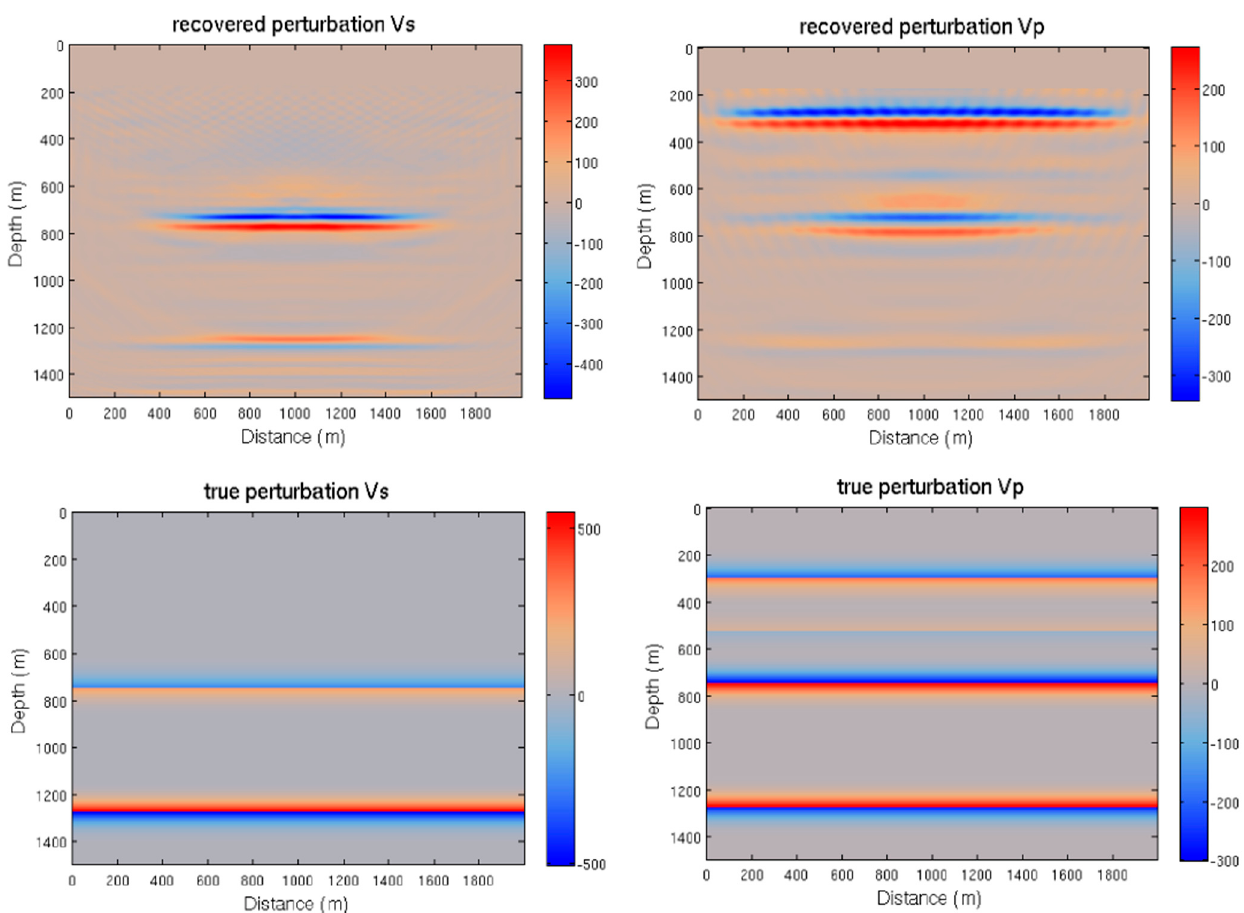
Figure 1. Minimisation for the data-space reflectivity: comparison of recovered depth reflectors (top) with the real image (bottom) for Vs (left) and Vp (right).